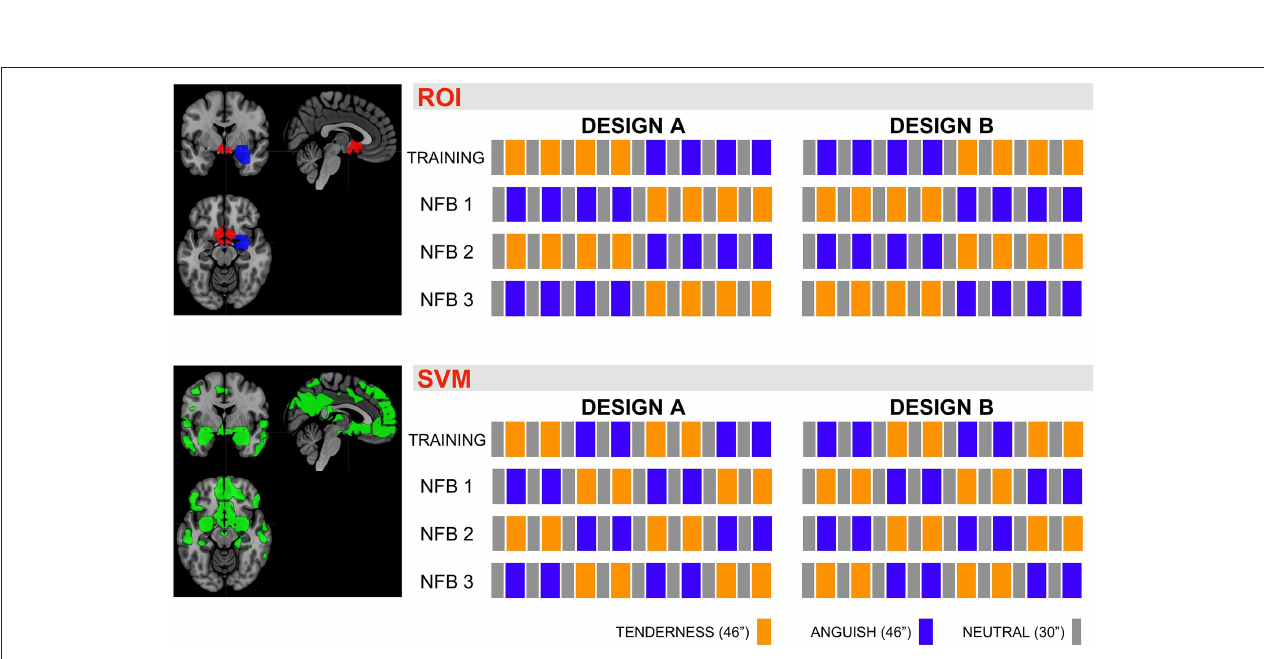
FIGURE 2 | Design of the NFB trials. Presentation order for the emotion blocks Neutral (“N,” gray boxes, 30 ′′ per block, with no music in the background), Tenderness (“T,” orange boxes, 46 ′′ per block, while playing one of the four tenderness music tracks) and Anguish (“A,” blue boxes, 46 ′′ per block, while playing one of the four anguish music tracks). The emotion blocks order was counterbalanced across trials A and B and runs 1–4. The sessions using the ROI = region of interest NFB method alternated the emotion blocks (top half) and the sessions using the SVM = support vector machine method presented the emotion trial blocks consecutively (bottom half), to reliably detect brain activity